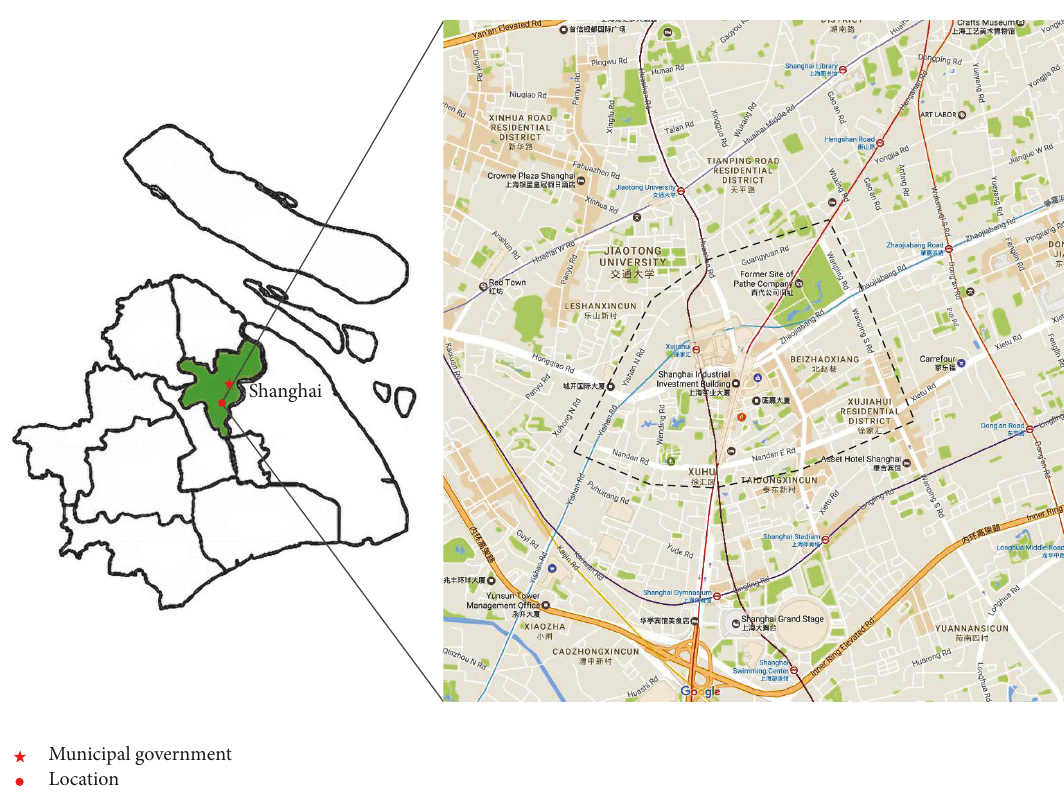
Figure 4: Location and layout of Xujiahui CBD, Shanghai, China.